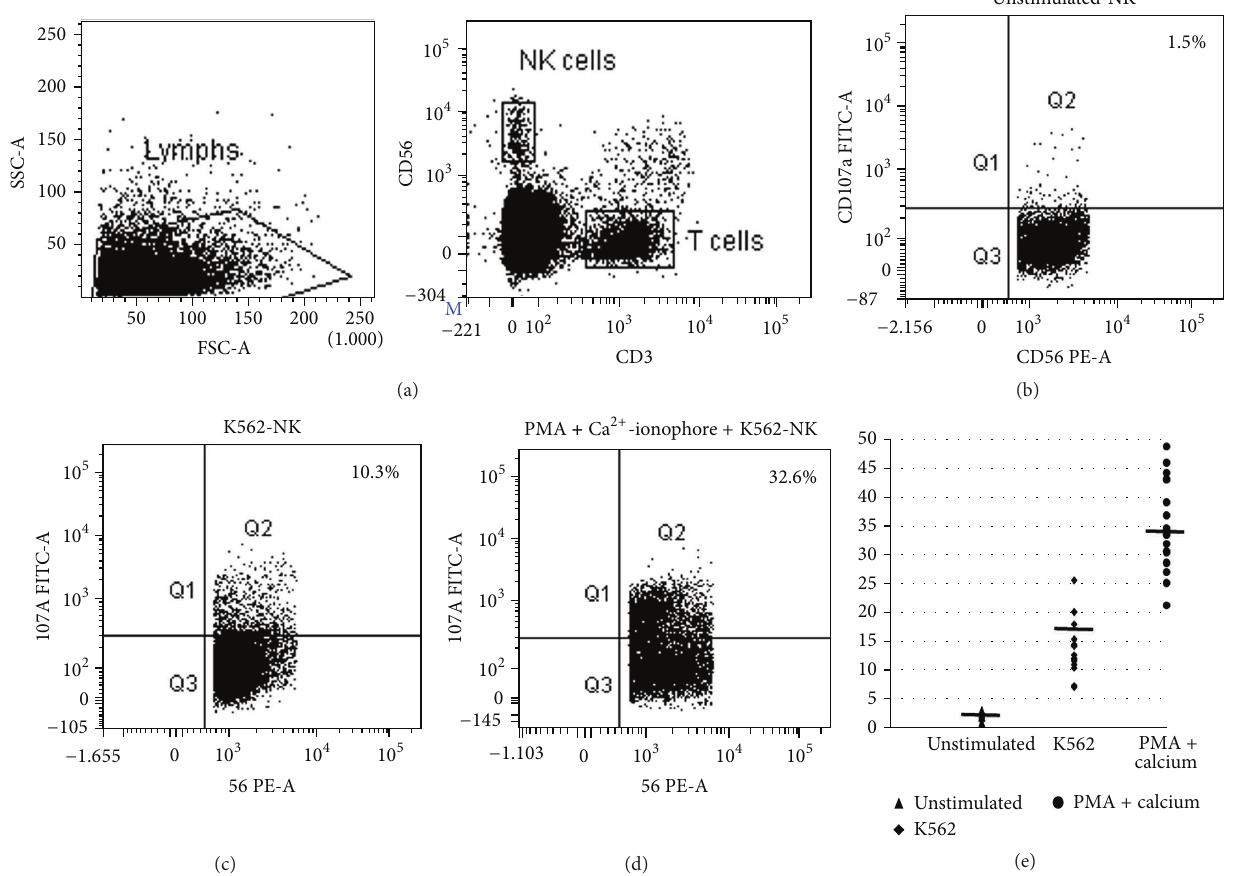
Figure 1: Comparison of conventional degranulation assay with modified assay. Whole blood was incubated with fluorescein isothiocyanate- conjugatedantiCD107aantibodyaloneorwithPMA+Ca 2+ -ionophoreorK562cellsfor2 h(asthreeseparatesamples).Sampleswereanalyzed by flowcytometry, gating onlymphocytes byforward/sidescatter. CD107aexpression wasanalyzed on naturalkiller (NK)cells (CD56 + CD3 − ), (a) and the increase in % CD107a + NK cells between unstimulated and stimulated samples was calculated. Results were considered valid if the healthy control sample processed along with the patient sample gave normal results. Patient results were considered abnormal if the increase was < 10% on stimulation. Flow cytometry figures represent the percent NK cells that express CD107a following no stimulation (b) and stimulation with K562 cells (c) or with PMA + Ca 2+ -ionophore (d) in a single representative subject. The dot plot represents the percent NK cells that express CD107a following no stimulation and stimulation with K562 cells or PMA + Ca 2+ -ionophore for all subjects tested in this study